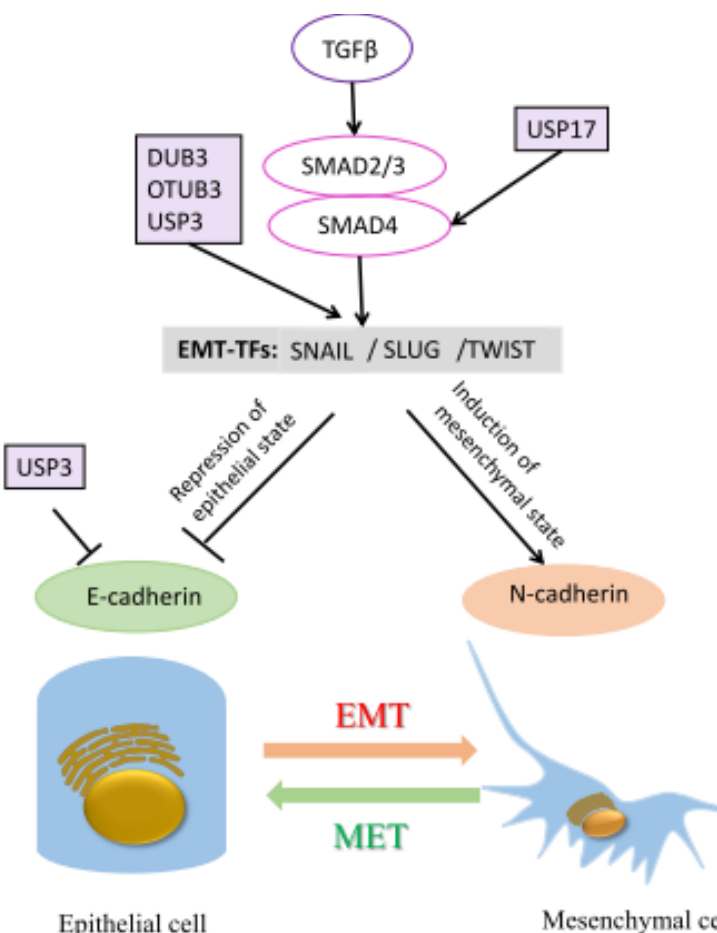
Figure 4. Roles of DUBs in epithelial–mesenchymal transition (EMT) in cancer metastasis. Epithelial cells are held together by numerous proteins, including tight junctions, adherens junctions, and desmosomes. These cells express molecules that are associated with the epithelial state, such as E-cadherin in epithelial state, and N-cadherin in mesenchymal state. Induction of EMT induces different EMT-inducing transcription factors (EMT-TFs) such as SNAIL, SLUG, and TWIST. These factors can then inhibit the epithelial state-related genes, such as E-cadherin, and activate the mesenchymal state related genes, such as N-cadherin. Various DUBs have been shown to interact with different EMT regulators. EMT is a reversible process, and mesenchymal cells can revert to the epithelial state by undergoing mesenchymal–epithelial transition (MET). A detailed description can be found in the main text.